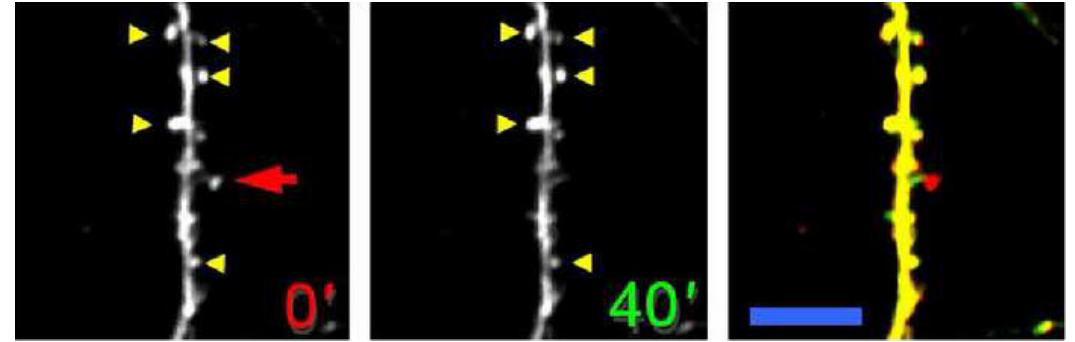
Fig. 6. Laser ablation of a single dendritic spine. Images of a portion of a dendrite before and 40 min after spine ablation. The yellow arrowheads indicate some stable spines on the irradiated dendrite. Scale bar, 15 (cid:1) m. Modi¯ed from Ref.